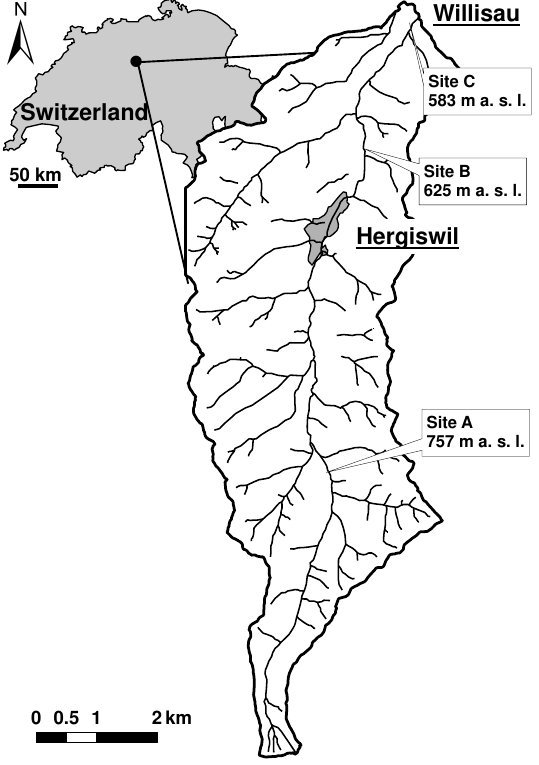
Fig. 1. Watershed of the river Enziwigger with the three field sites A, B and C and the towns Willisau and Hergiswil (Canton of Lucerne,